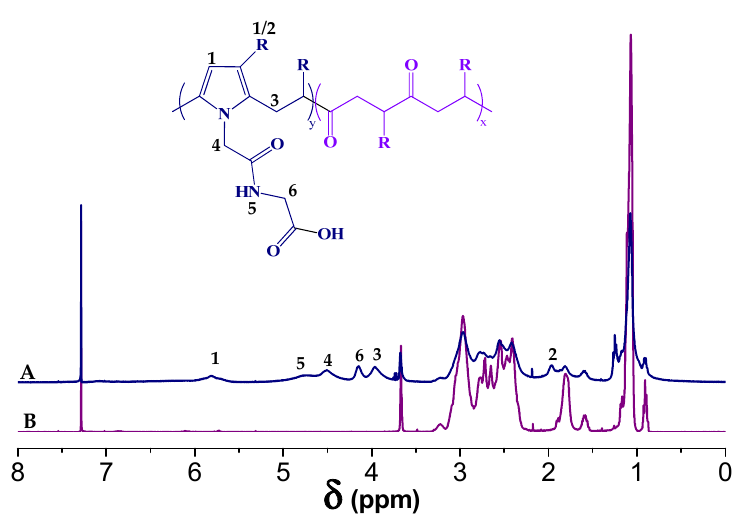
Figure 2. 1 H-NMR spectra of ( A ) PK30 functionalized with Gly-Gly and ( B ) pristine PK30 in CDCl 3 .